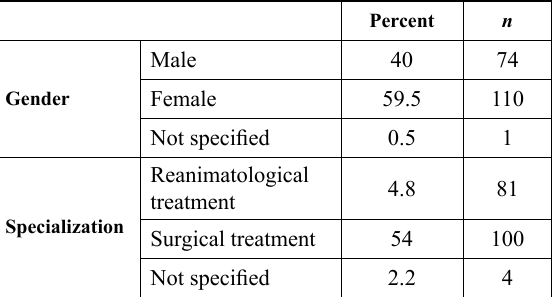
Table 1. Descriptive statistics of subjects by gender and